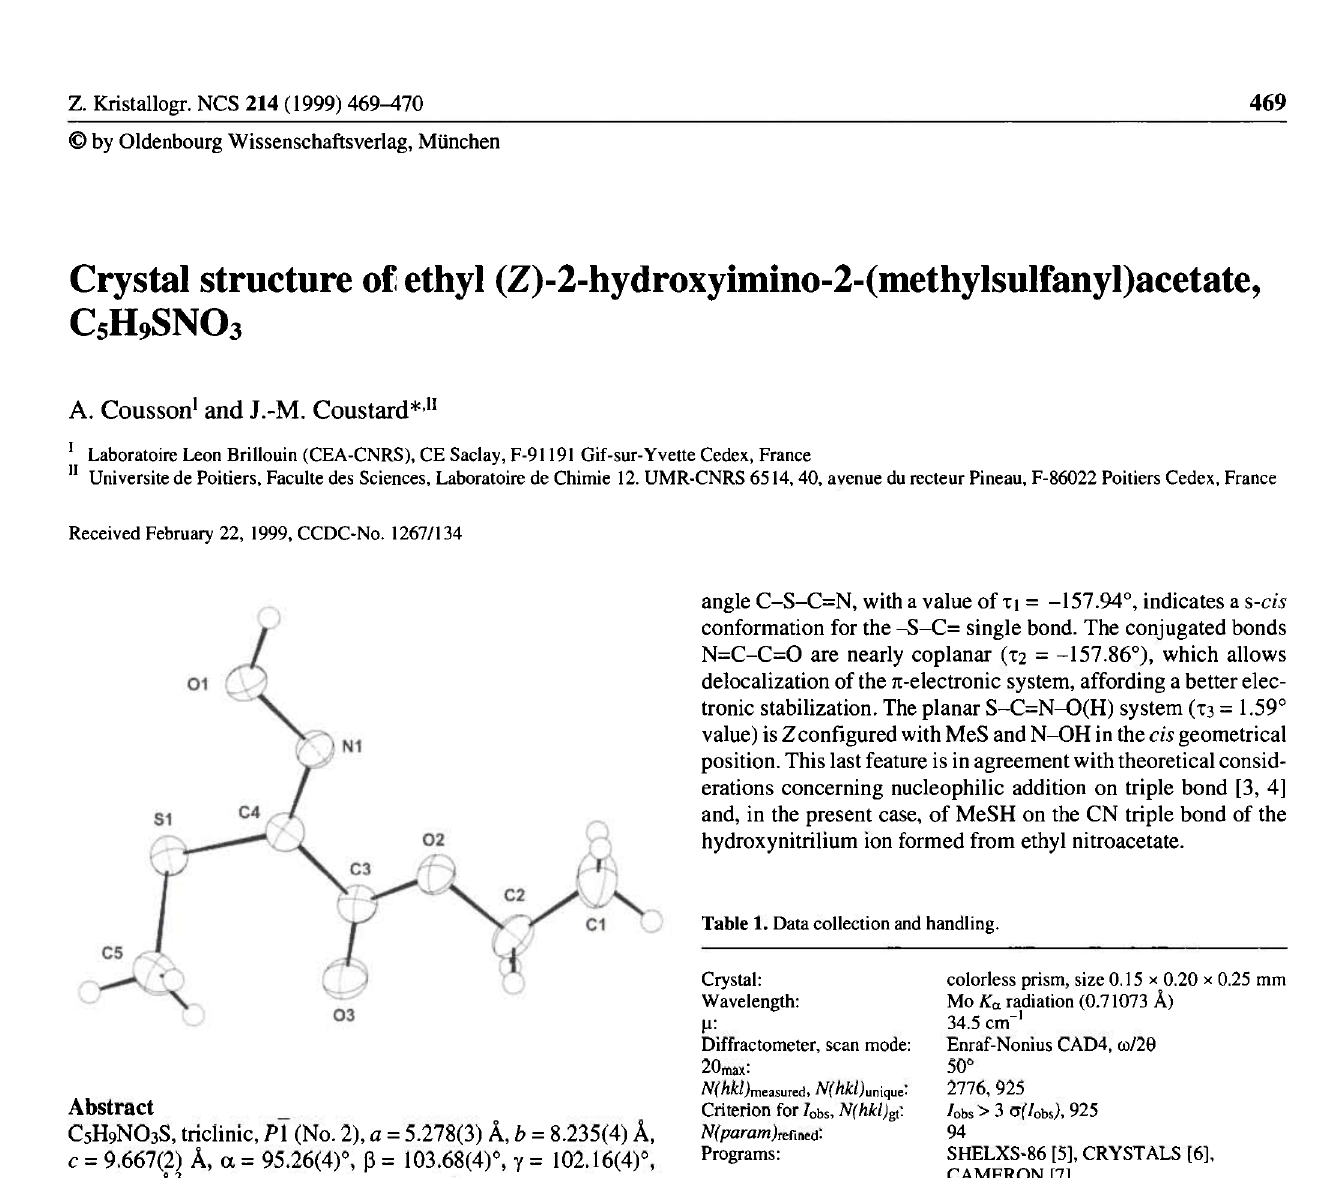
Table 2. Atomic coordinates and displacement parameters (in Ä 2